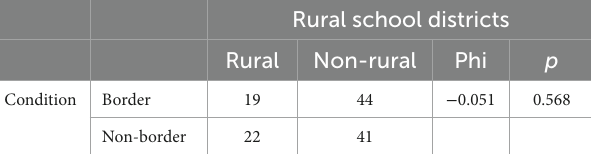
TABLE 2 Chi-square results from comparing border and non-border school districts’ rural districts.